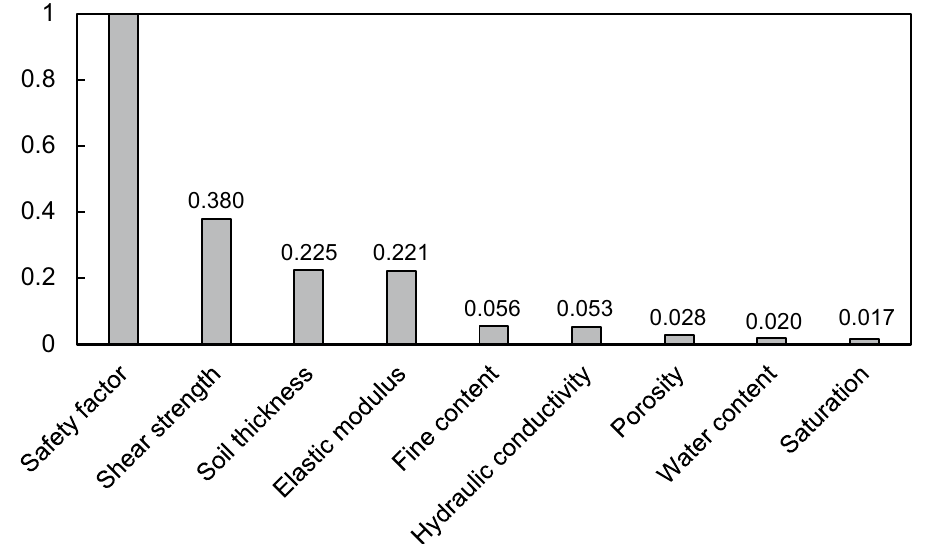
Figure 19. Importance of input variables based on random forest.